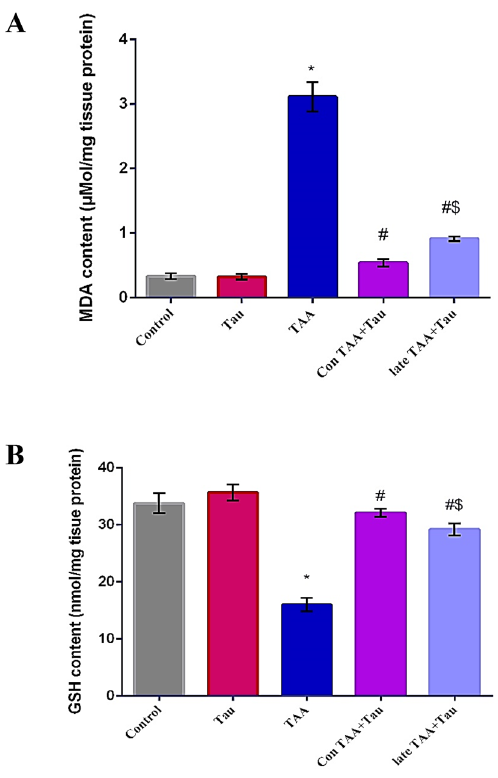
Figure 1. ( A ) MDA content in control, Tau, TAA, Con TAA + Tau and late TAA + Tau groups. ( B ) GSH content control, Tau, TAA, Con TAA + Tau and late TAA + Tau groups Values were expressed as mean ± SE. Number of rats in each group was 6. MDA: malondialdehyde, GSH: reduced glutathione, Tau: taurine, TAA: thioacetamide *: Significance against control group ( P < 0.05). # Significance against TAA group ( P < 0.05). $: Significance against Con TAA + Tau group ( P <